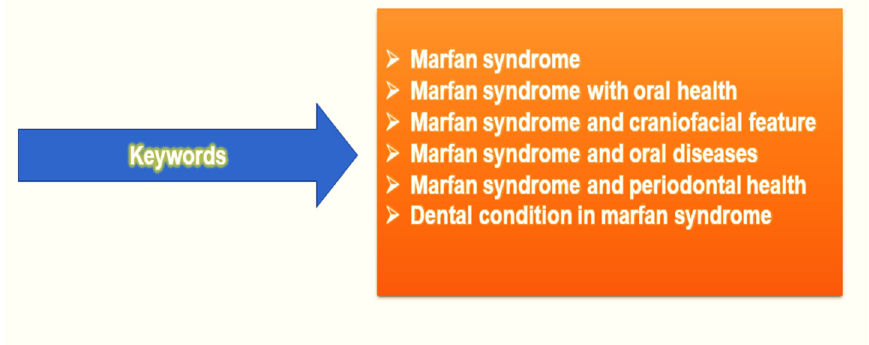
Figure 3. Keywords used for data searching.